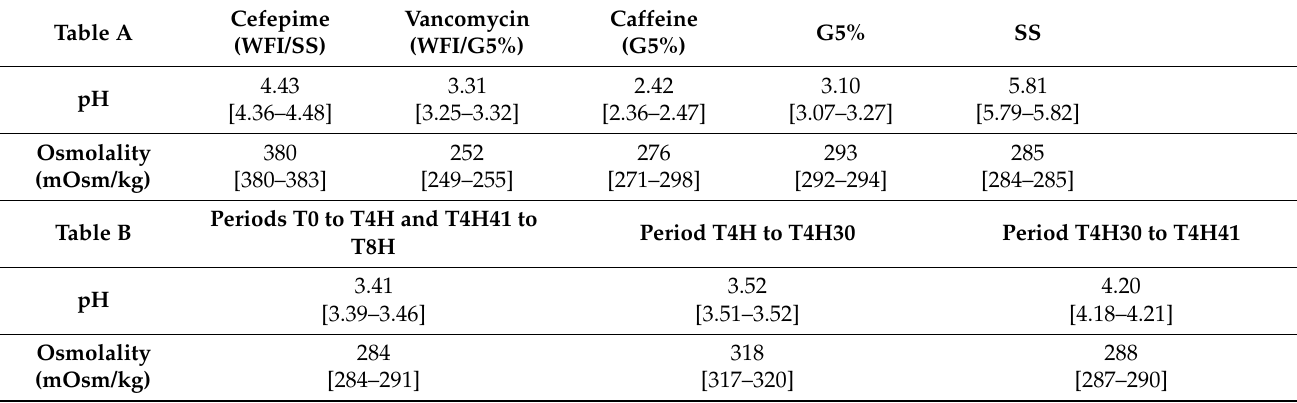
The pH median changes during infusion (Table 2B). Table 2. pH and osmolality measurements of the different infusion solutions ( A ) ( n = 3). pH and osmolality measurements at the exit of the catheter at different infusion times. T0 to T4H and T5H to T8H: vancomycin and G5% infusion; T4H to